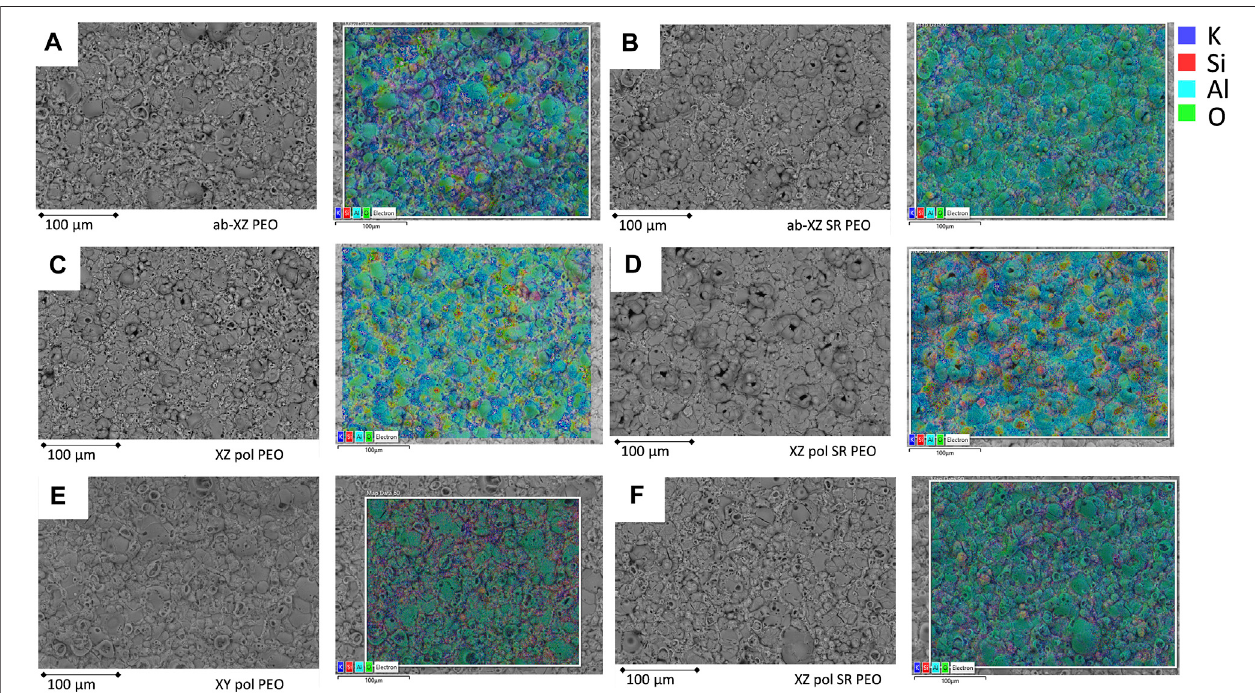
FIGURE 3 | PEO on the different printed surfaces; left: BSE-SEM fi gure; right: EDS elemental distribution of the same position; (A) , (B) XZ-ab PEO; (C) , (D) XZ-pol PEO, (E) , (F) XY-pol PEO.